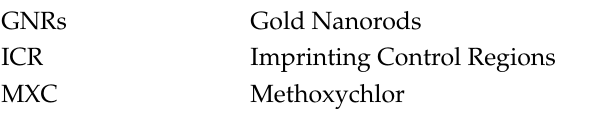
Figure S1: Expression profiles of Ano1 , Na1pl5 , Peg3 , Slc22a2 and Plagl1 , Table S1: List of primers used to test the expression of the 44 imprinted genes and the reference genes Gapdh and U6 , Table S2: List of 44 homologous imprinted